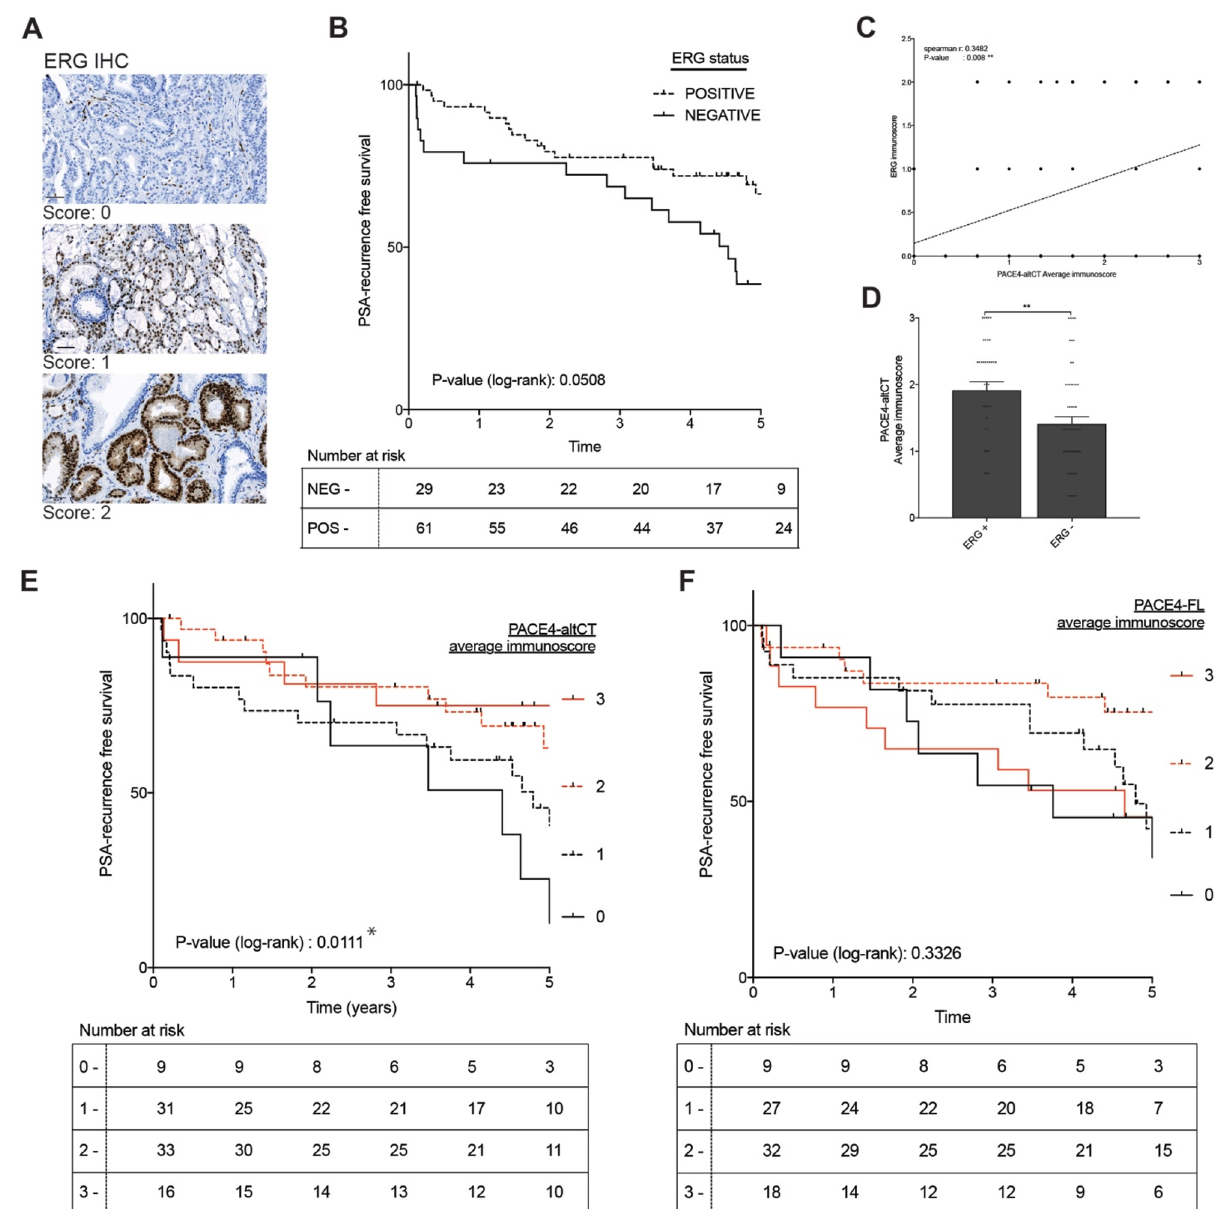
Figure 3. PACE4-altCT relationship with tumor ERG status and biochemical recurrence in prostate adenocarcinomas. ( A ) Representative images of prostate epithelial cells stained for ERG with the different scoring units used. Magnification: 20x, scales represent 50 µm. ( B ) Kaplan–Meier analysis of patient biochemical recurrence (PSA-based) according to their tumor primary Gleason pattern immunoscores for ERG. Gehan- Breslow-Wilcoxon test P-value: 0.0282. ( C ) Correlation analysis between PACE4-altCT and ERG immunoscores in the analyzed cores. All individual coordinates are shown (but are overlaid for identical data). The dashed line represent the linear regression. ( D ) Averaged immunoscores of tumor cores according to their ERG status. ERG + includes both ERG immunoscores 1 and 2. ( E ) Kaplan–Meier analysis of patient biochemical recurrence (PSA-based) according to their tumor primary Gleason pattern immunoscores for PACE4-altCT or PACE4-FL ( F ). Log (rank) Mantel: * indicates P value < 0.05, ** < 0.01 and *** <